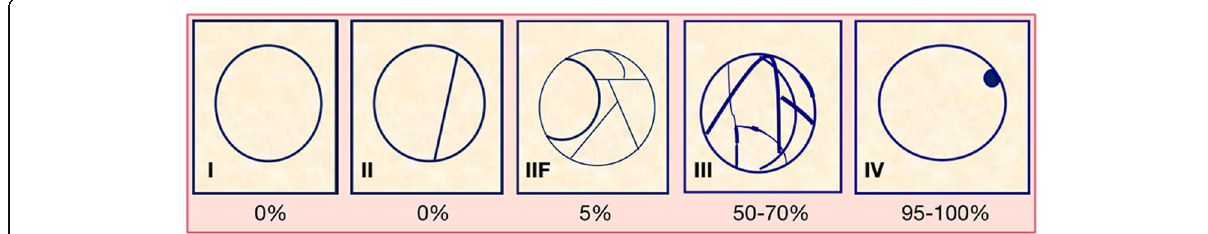
Fig. 14 Schematization of Bosniak ’ s classification for cystic renal masses and associated malignancy rate. Bosniak I: hairline-thin wall without septa, calcifications, or solid components; malignancy rate of 0%. Bosniak II: few hairline-thin septa, fine calcifications in a short segment of the wall, or slightly thickened calcification; malignancy rate of 0%. Bosniak IIF: multiple hairline-thin septa, smooth minimal thickening of the wall or septa, and thick or nodular calcifications; malignancy rate of 5%. Bosniak III: thickened irregular wall or septa with enhancement after the administration of contrast agent; malignancy rate of 50 – 70%. Bosniak IV: soft tissue enhancing mass independent of the wall or septa; malignancy rate of 95 – 100%. Remember that Bosniak I – II cysts do not need follow-up, Bosniak IIF cysts need follow-up, and surgery is indicated for